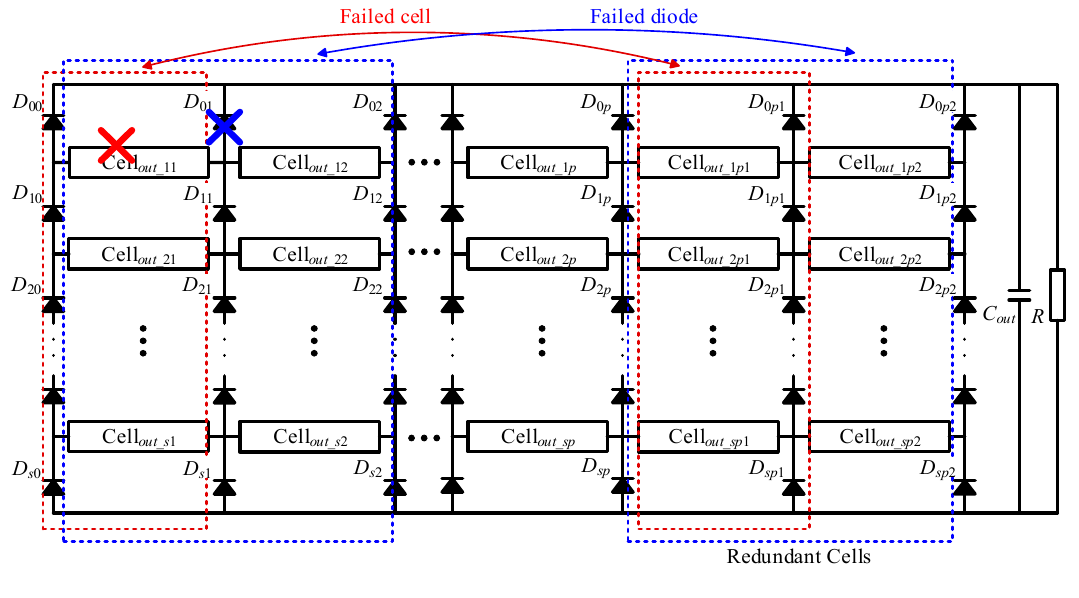
Figure 10. Fault tolerance with redundancy.